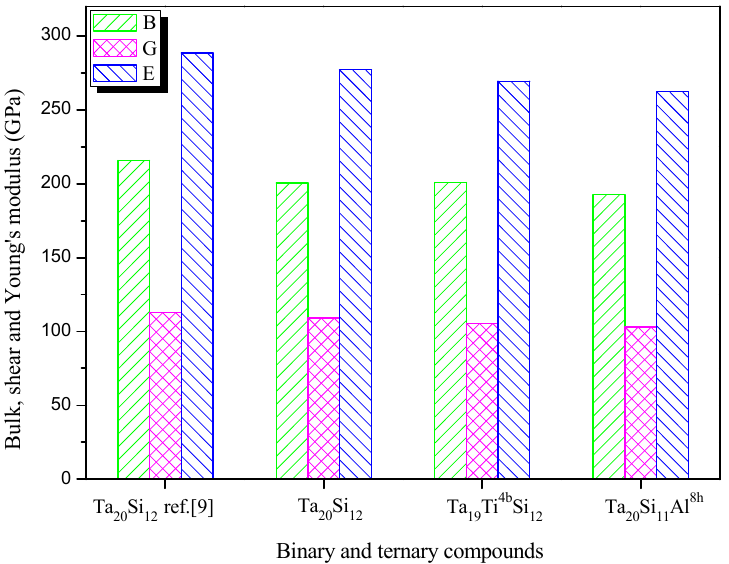
Figure 3. Calculated bulk modulus ( B ), shear modulus ( G ) and Young’s modulus ( E ) for the binary and ternary D8 m ‐ structured Ta 20 Si 12 .